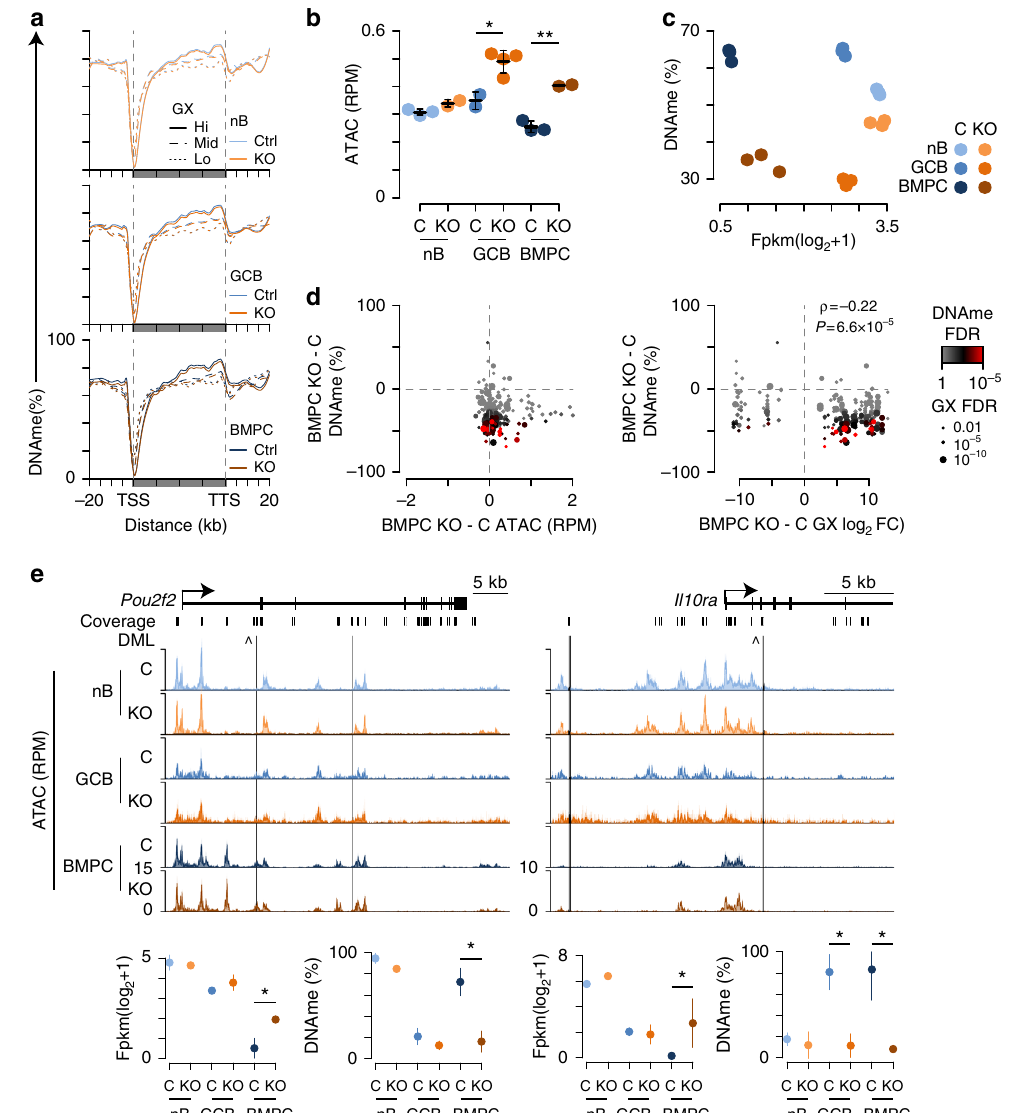
Fig. 6 De novo DNA methylation accompanies gene repression in BMPC. a Average DNA methylation (DNAme) relative to the transcription start site (TSS) and transcription termination site (TTS) of genes strati fi ed by expression level in lymph node B220 + GL7 − Fas − naive B cells (nB; top), B220 + PE + GL7 + Fas + germinal center B cells (GCB; middle), and CD138 + BMPC (bottom) for both Cd19 cre/ + Dnmt3a fl / fl Dnmt3b fl / fl (KO; orange) and littermate control (C; blue). b Average ATAC-seq accessibility measured at Dnmt3-dependent differentially methylated CpGs. c Average gene expression and DNAme at Dnmt3-speci fi c differentially expressed genes ( N = 90) with proximal differentially methylated loci ( N = 210). d Scatterplot of accessibility change by DNA methylation change for Dnmt3 differentially methylated loci (left), and differentially expressed genes and methylated loci from c in BMPC. Spearman's correlation coef fi cient ( ρ ) and signi fi cance of correlation are shown. e Examples of differentially expressed genes and methylated loci at the Pou2f2 and Il10ra loci are shown. A schematic of the gene is shown (top) with examples of gene expression and DNA methylation changes shown below. The carrot (^) denotes the CpG shown below. Data are from 5 experiments and 36 mice as described (Figs. 3 – 5). Mean ( a , c , d , e ) and standard deviation are shown ( b , e